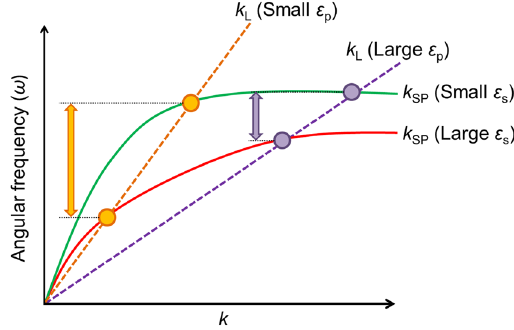
Figure 2. Schematic of the dispersion relations of surface plasmon (solid lines) with small (green) and large (red) surrounding dielectric constants on the metal ( ε s ), and the light lines in the prisms (dashed lines) with small (orange) and large (purple) dielectric constants ( ε p ). Circles and arrows represent the SPR excitation points and angular frequency differences between the small ε s and large ε s ,